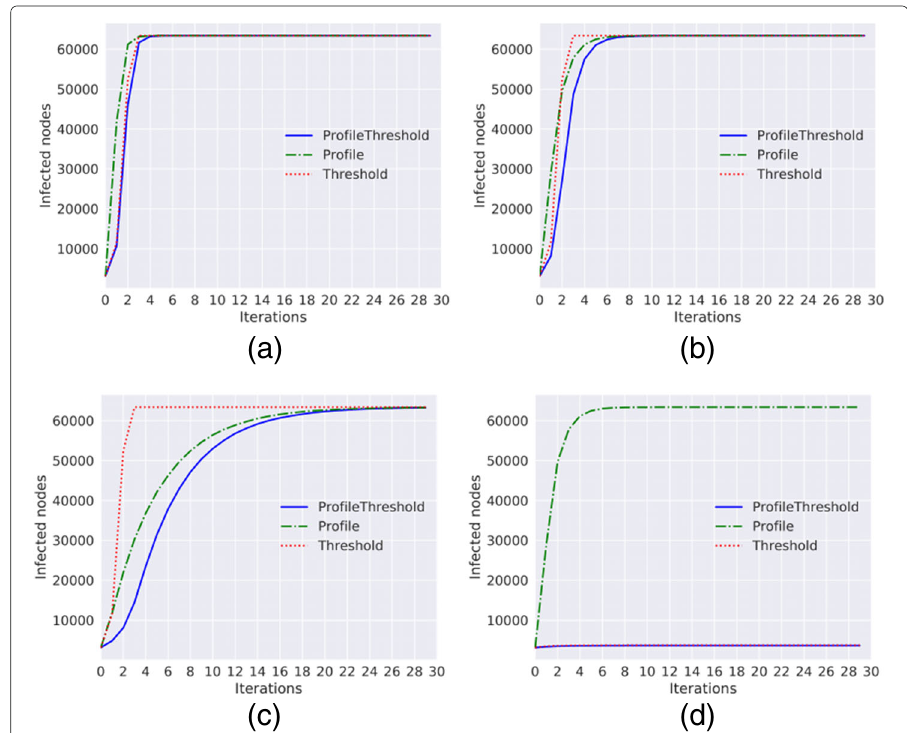
Fig. 2 Diffusion trends for the Erdós-Renyi graph. Diffusion trends for Threshold , ProfileThreshold and Profile model with a = 0 and p = 0 and with different values of γ and τ . a γ = 0.1, τ = 0.1 b γ = 0.4, τ = 0.1 c γ = 0.8, τ = 0.1 d γ = 0.4, τ = 0.2